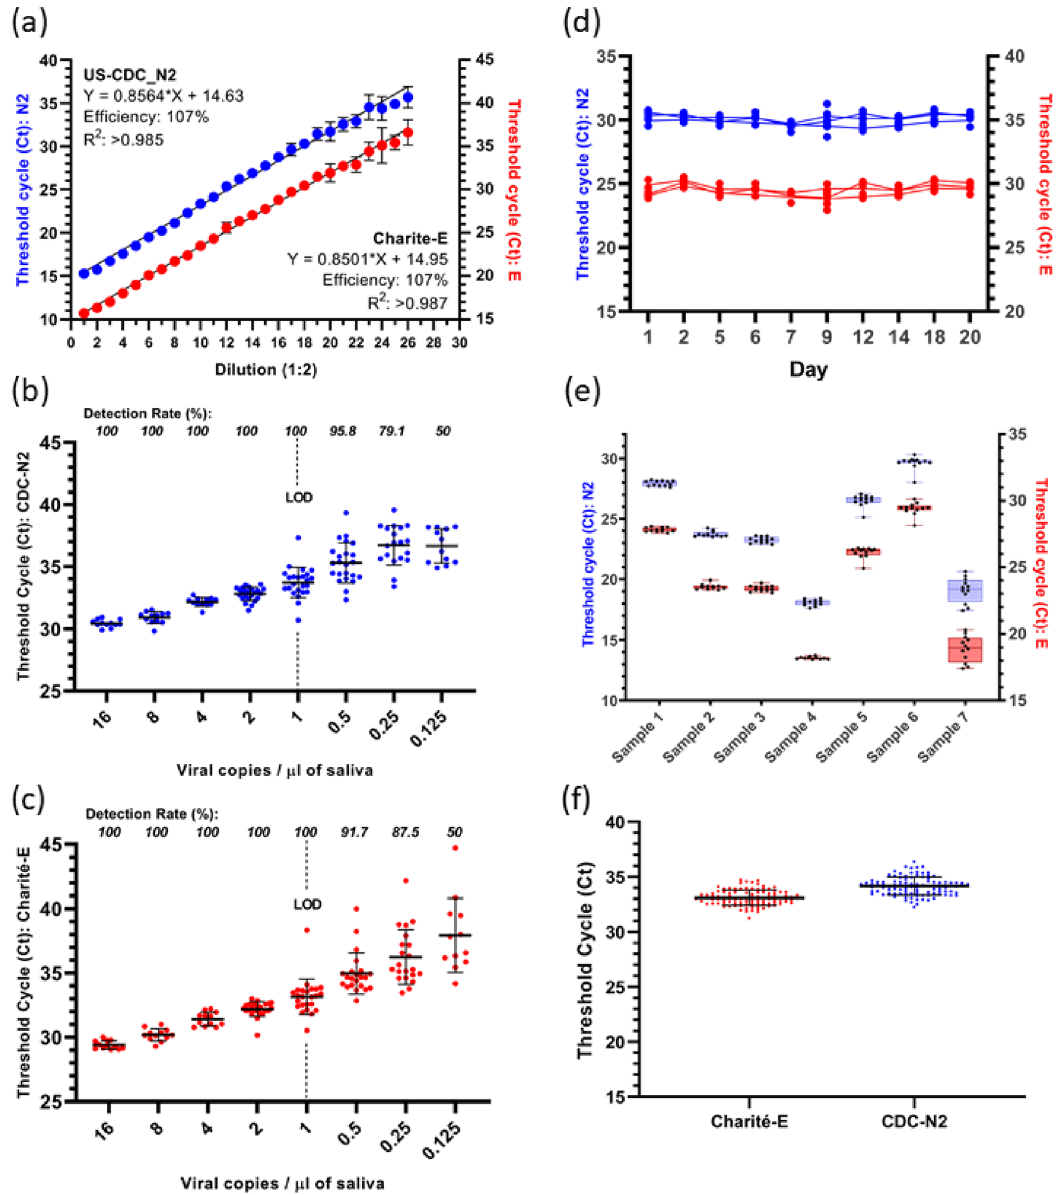
positive clinical sample, spanning a range of high-to-low viral loads. The detection rates and LOD for the N2 and E assays are shown in panels ( b ) and ( c ) respectively. ( d ) The CT values of a positive sample tested over 20 days under various storage conditions. ( e ) Robustness results between operators and reagents. ( f ) Repeatability and reproducibility when sequentially testing a commercial standard at near-LOD daily for 100